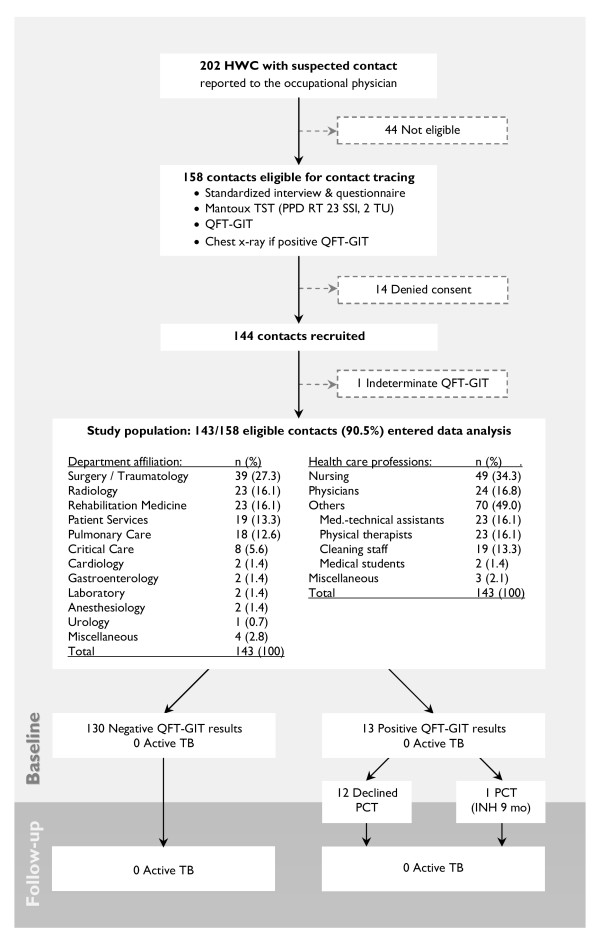
Study profile. HCW = health care workers; IGRA = interferon-γ release assay. PCT = preventive chemotherapy; PPD = purified protein derivate; QFT-GIT = QuantiFERON®-TB Gold in Tube; TST = tuberculin skin test.